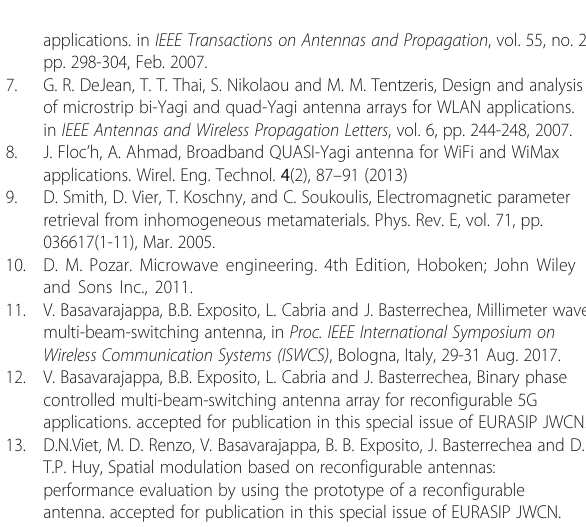
reconfigurable array setup applied to practical scenar-